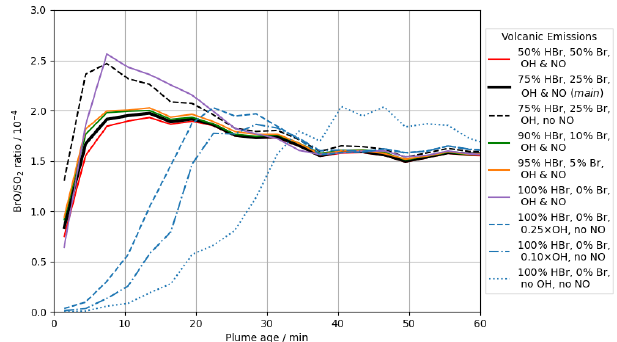
Figure 12. Modelled in-plume BrO / SO 2 ratio at 12:00UTC on 2012-08-01 versus plume age for the following model runs: br50_50 (red, solid), main (black, solid), NO_00 (black, dashed), br90_10 (green, solid), br95_5 (orange, solid), br100_0 (purple, solid), OH_25 (blue, dashed), OH_10 (blue, dash-dotted), and no- HighT (blue,